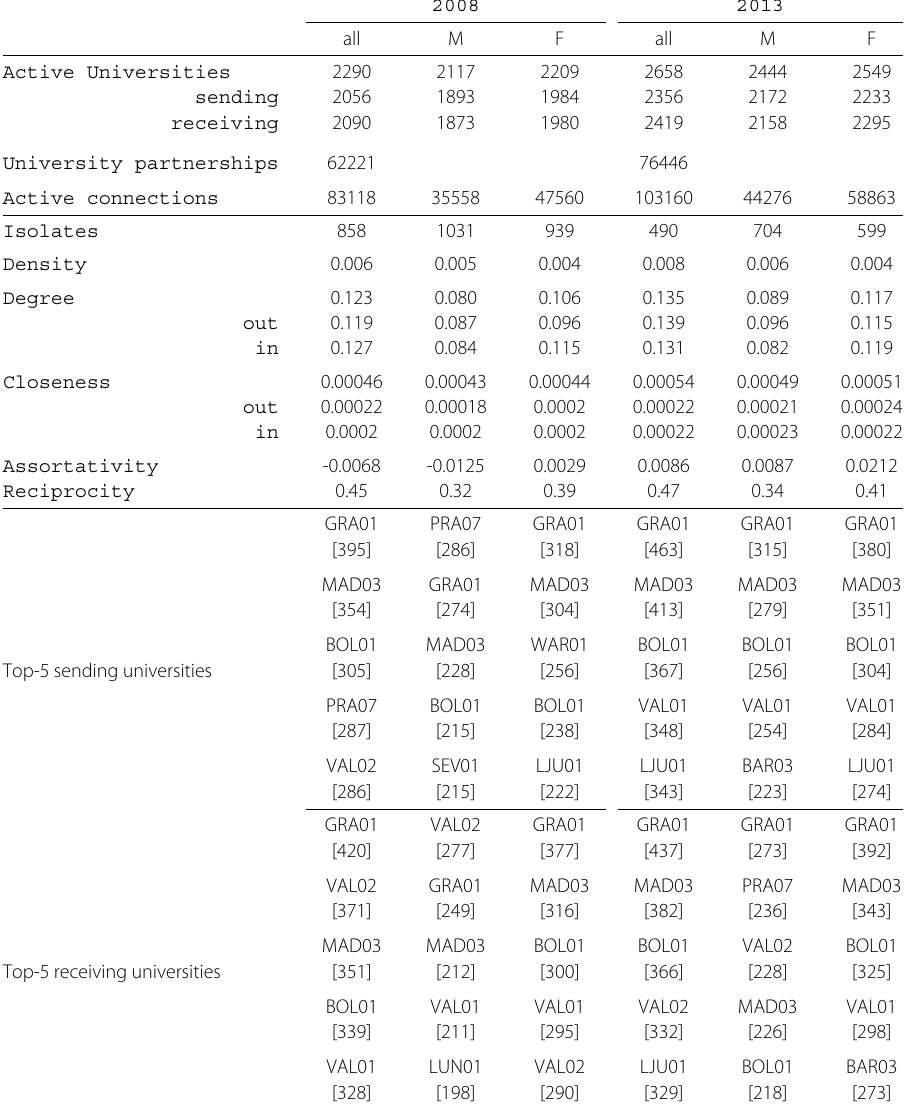
Table 2 Summary statistics - Erasmus network - 2008 and